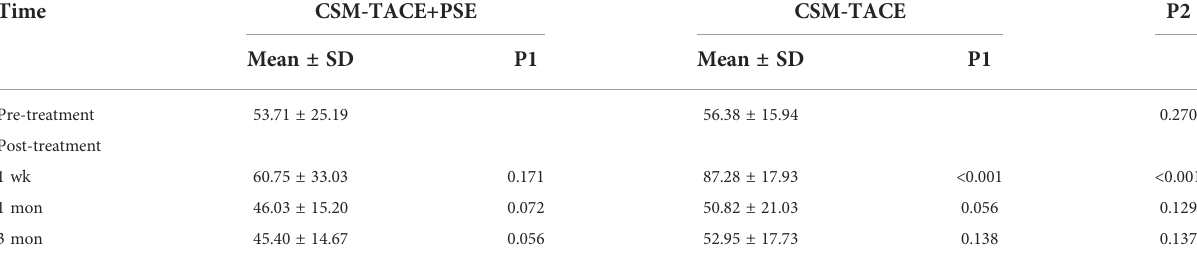
TABLE 5 Follow-up results of alanine aminotransferase (ALT) counts (U/L). Time